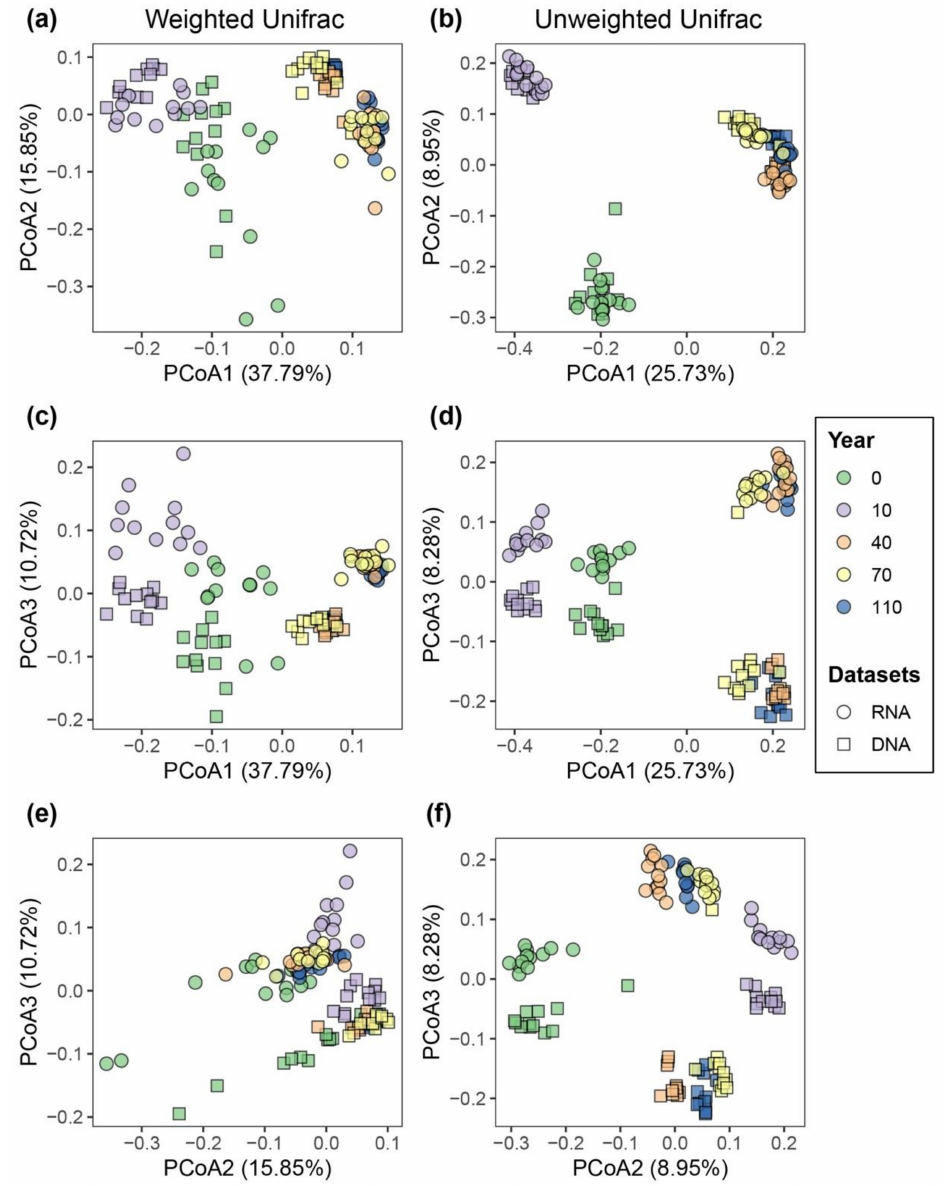
Figure 2. β -diversity patterns of bacterial communities displaying di ff erences according to soil successional stages and sequencing approach (i.e., DNA- or RNA-based). Weighted ( a , c , e ) and unweighted ( b , d , f ) UniFrac distances were used to calculate β -diversity, which was visualized using principal coordinate analysis (PCoA). PCoA results are illustrated in di ff erent ordinate axes. Colors represent successional stages (i.e., 0, 10, 40, 70 and 110 years of succession), and di ff erent shapes represent RNA- and DNA-based approaches. The percentages in the axes show the variation of species composition explained by each